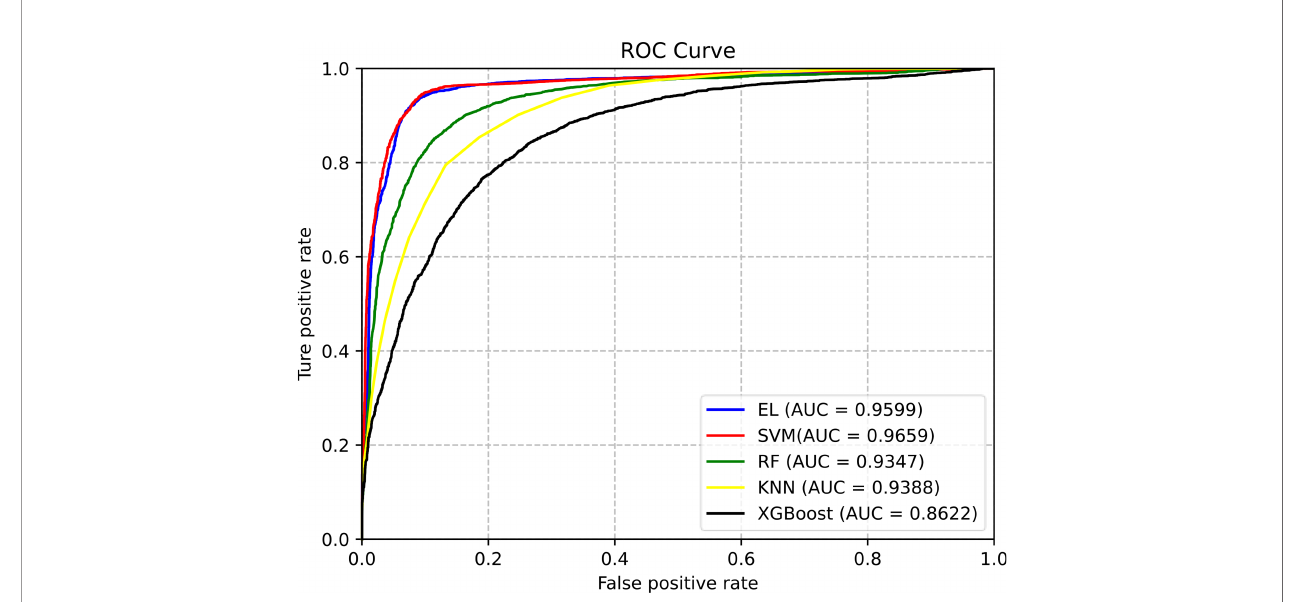
FIGURE 4 | The ROC curves of different classi fi cation methods for predicting pupylation sites. (EL is the abbreviation of ensemble learning).